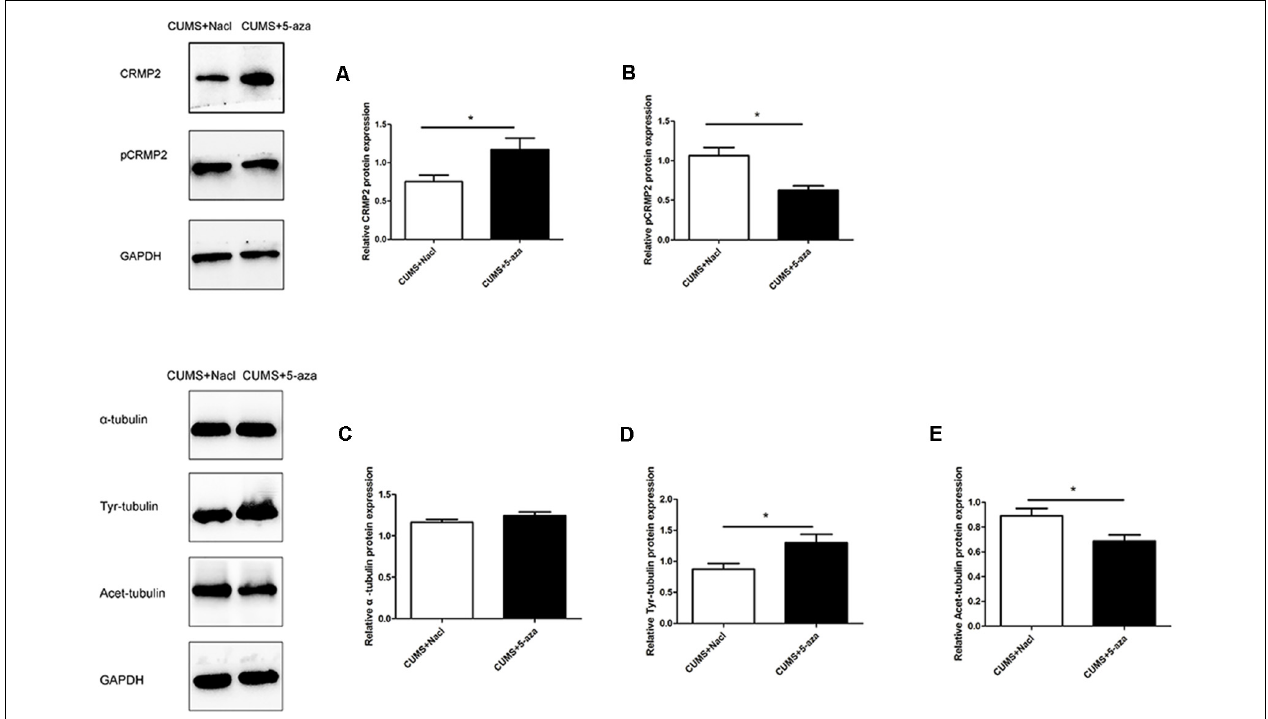
FIGURE 8 | Effect of 5-aza treatment on CRMP2 (A) , pCRMP2 (B) , and α -tubulin ( α -tubulin: C ; Tyr-tubulin: D ; Acet-tubulin: E ) isoform expression. * P < 0.05.